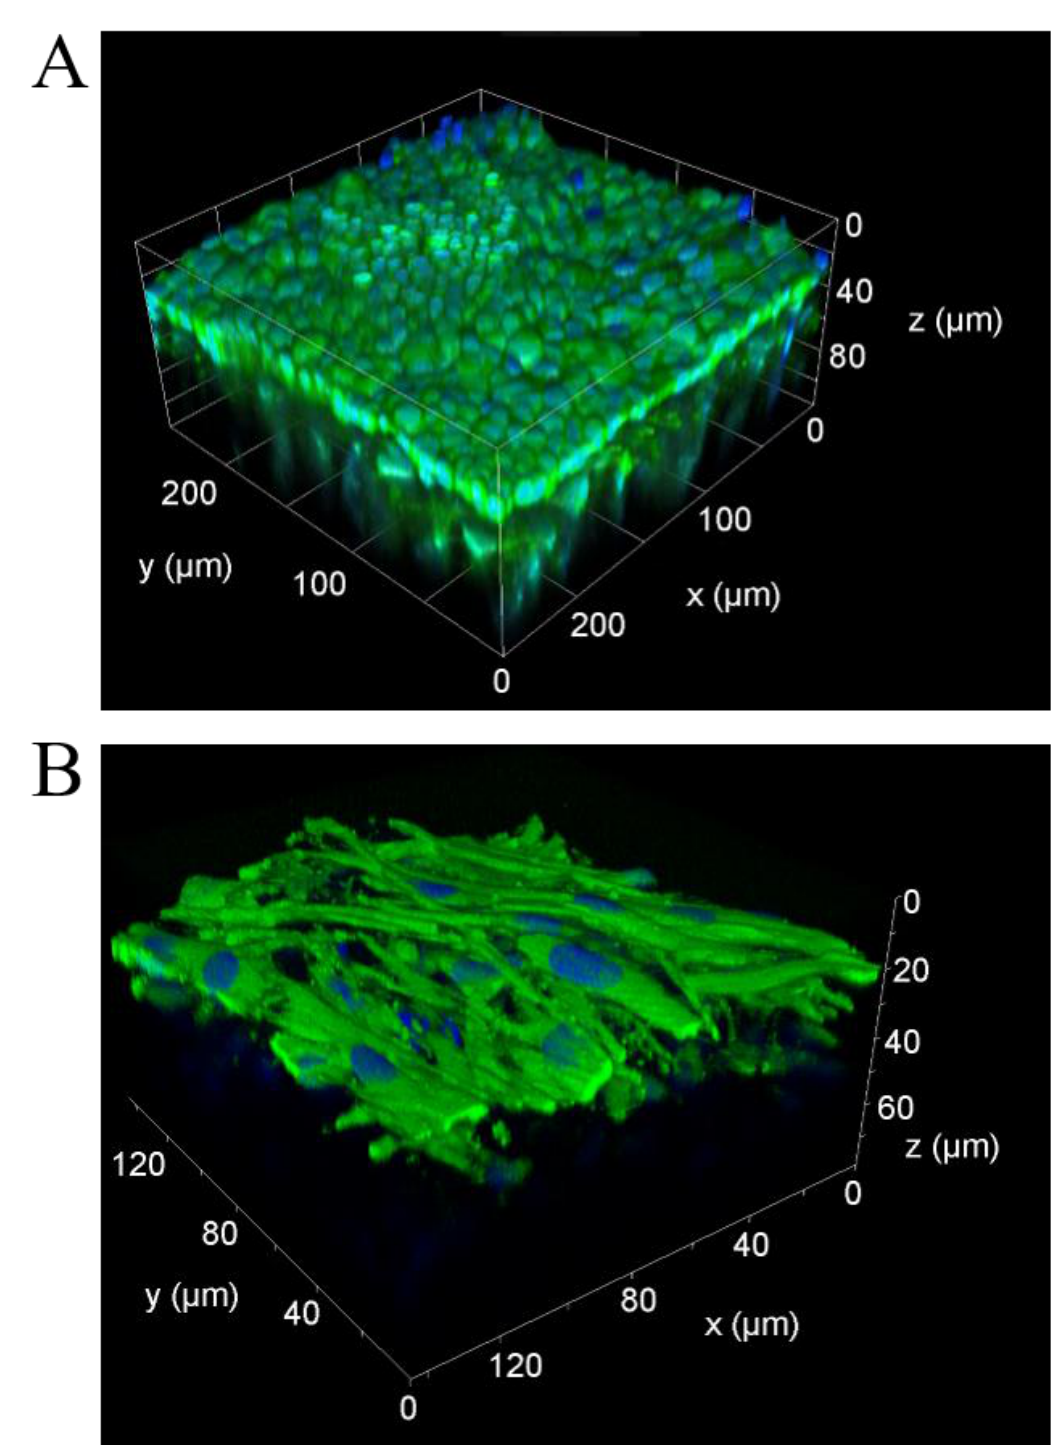
Figure 3. In 3D airway tissue models, tight epithelial layers form and hpF migrate into the collagen scaffold. ( A ) Volume reconstruction of images captured by two-photon microscopy. x, y -axis = 250 µ m, z -axis = 120 µ m. ( B ) 3D reconstruction of confocal images taken from the bottom shows hpF in the collagen scaffold. x, y -axis = 140 µ m, z = 70 µ m. Cells were stained with calcein-AM (green) and nuclei with Hoechst 33342